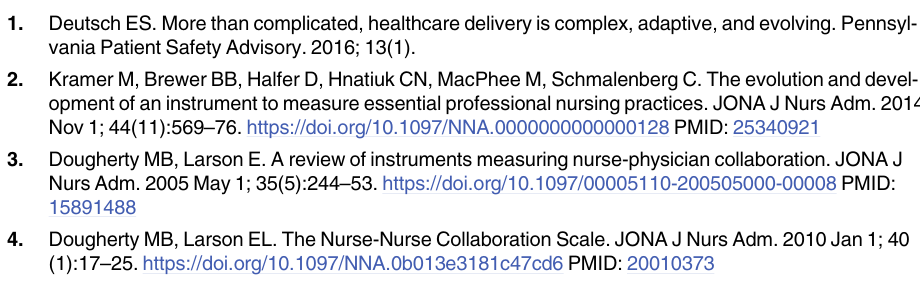
S5 Dataset. Phase 3 cognitive interviews content node count. (XLSX) S6 Dataset. Phase 4 pilot survey data.